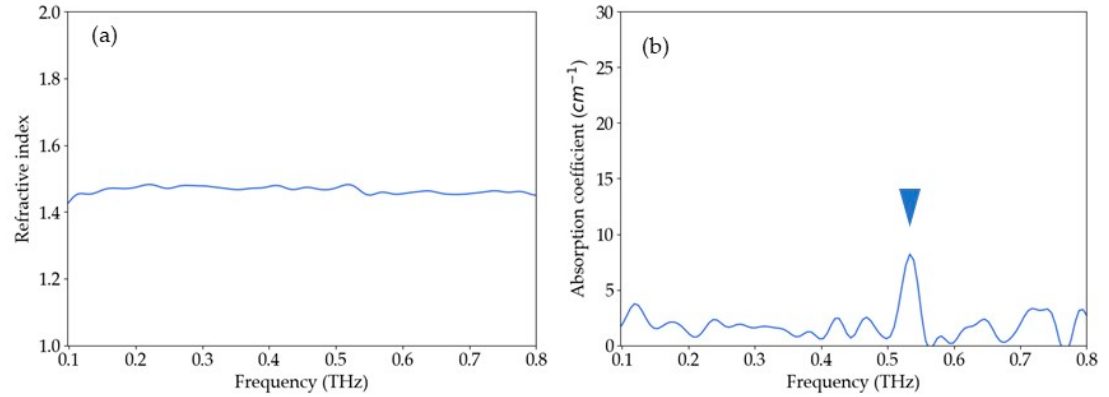
Figure 5. ( a ) The refractive index and ( b ) the absorption coefficient of the packaged sample. The absorption peak at 0.53 THz is clearly visible, as shown by the arrowhead. Since the penetration depth of the evanescent wave is smaller than the thickness of the plastic bag at high frequencies, the absorption features of the lactose sample at high frequency cannot be measured reliably. Therefore, the absorption coefficient is shown up to 0.8 THz.